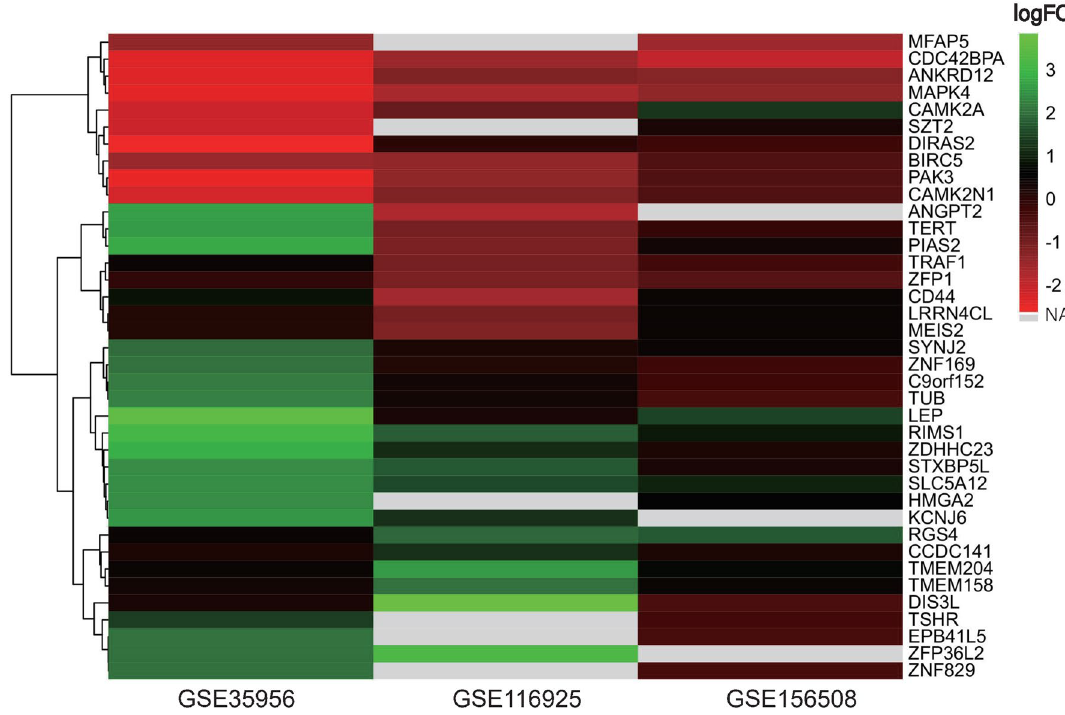
Figure 5. Heatmap for the 38 target genes in the circRNA–miRNA–mRNA network by GEO data